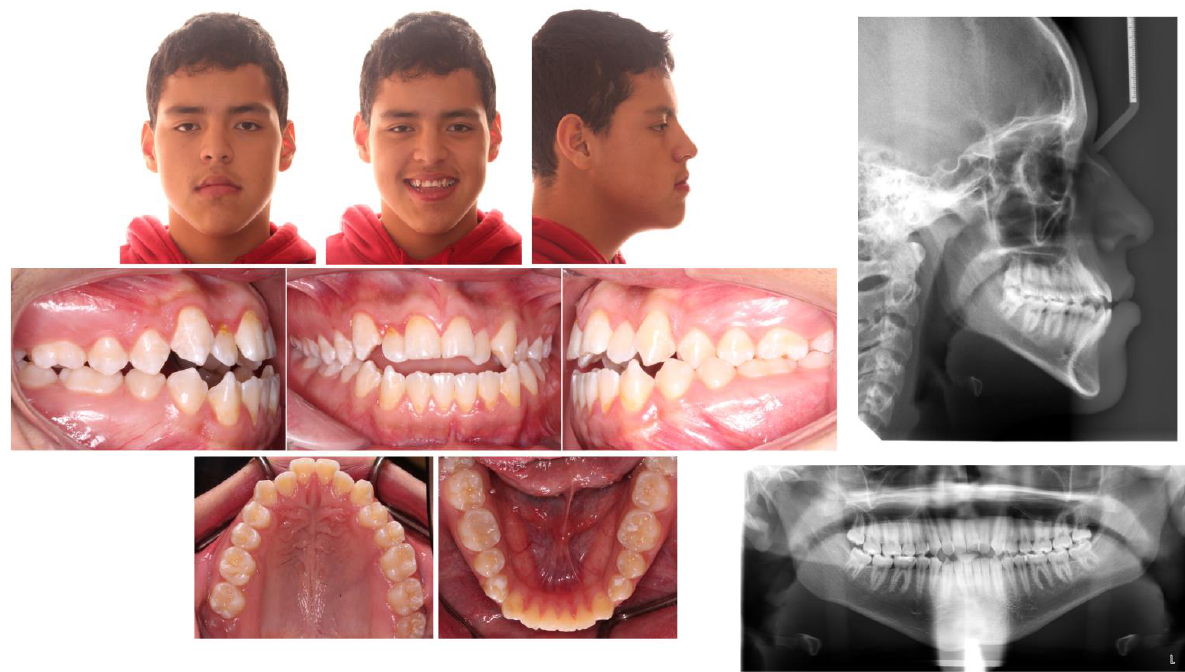
Figure 1. Pretreatment facial and intraoral photographs. Table 1. Cephalometric